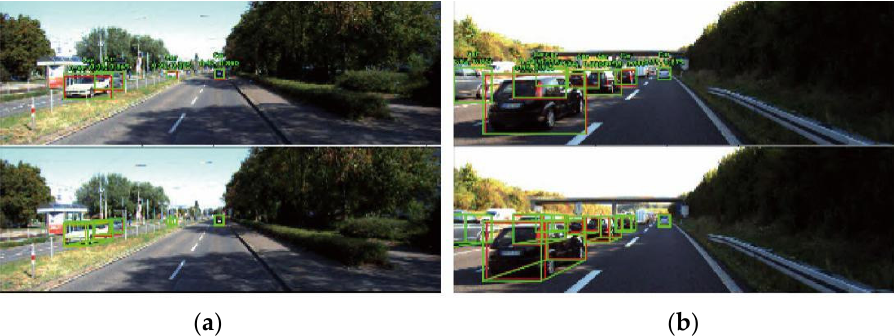
Figure 12. Illumination scene experiment results: ( a ) shade shading; and ( b ) light blocking.